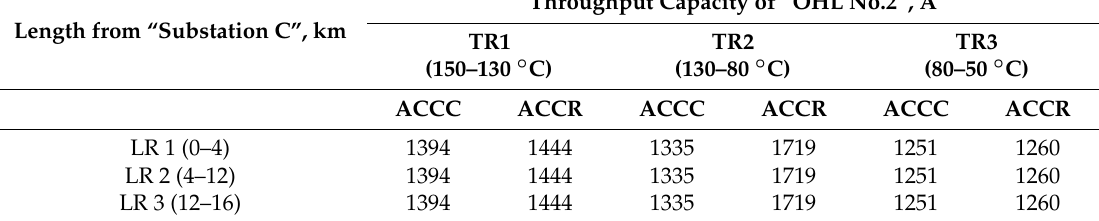
Table 9. Capacity comparison of ACCC and ACCR types based on selected final cross-sectional areas of conductor for “OHL No.2”.